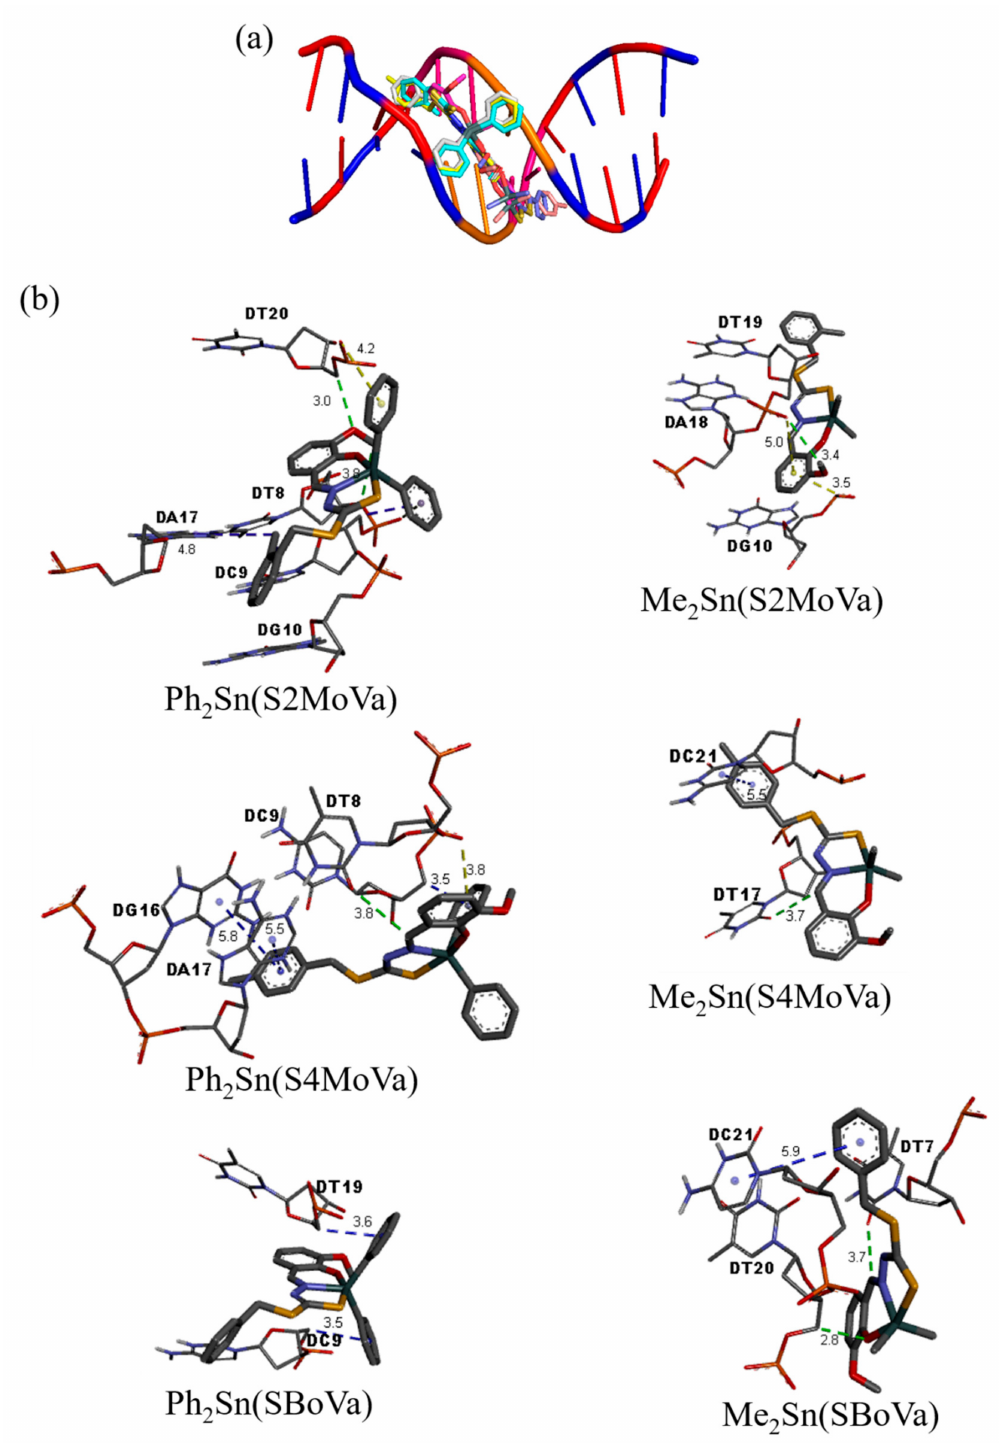
Figure 9. ( a ) Schematic representation of organotin(IV) compounds that fit well in the grooves of the DNA strand obtained by docking simulations. The two double-stranded DNA comprise of the phosphate deoxyribose backbone with guanine (DG, red), cytosine (DC, blue), adenine (DA, pink) and thymine (DT, orange). ( b ) Molecular interactions of organotin(IV) compounds within the grooves of double stranded DNA